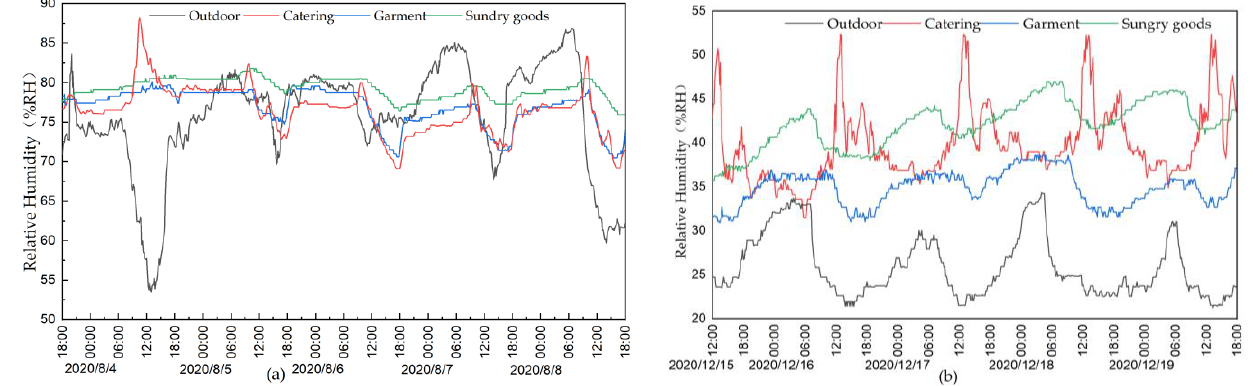
Figure 5. Variation of relative humidity in summer ( a ), and winter ( b ).